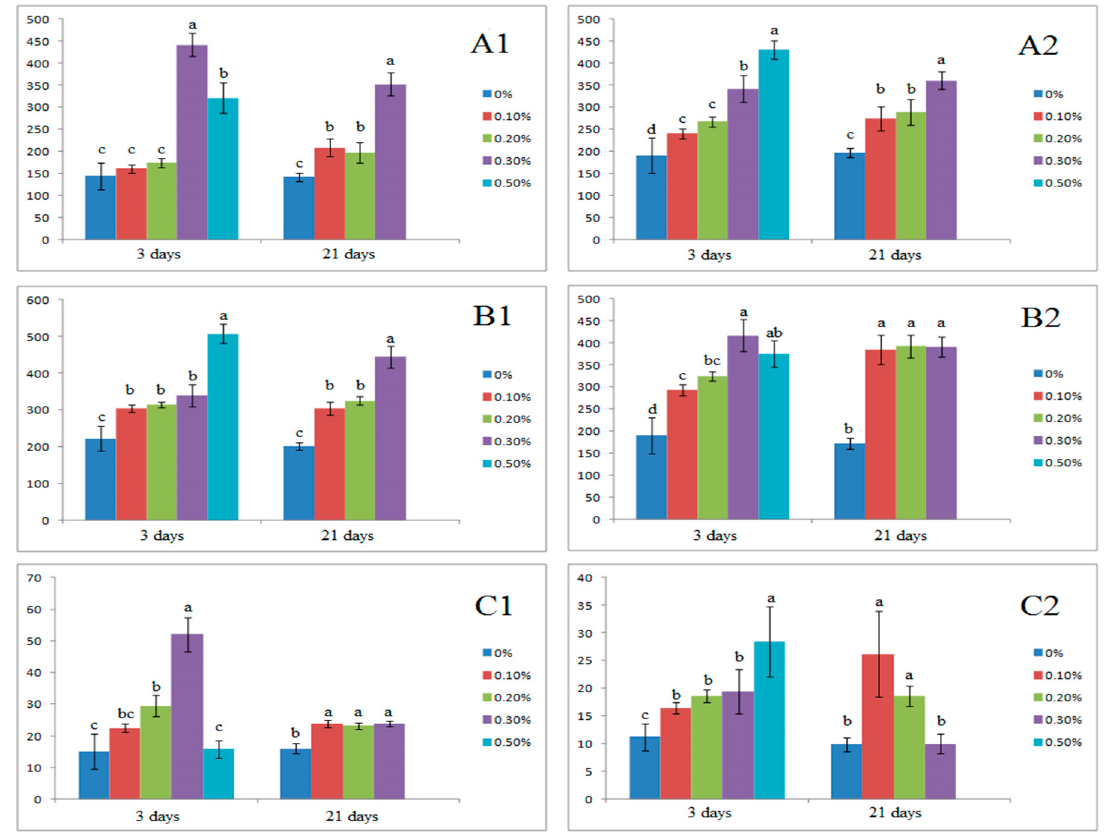
Figure 3. SOD activity in leaves ( A1 ), SOD activity in roots ( A2 ), CAT activity in leaves ( B1 ), CAT activity in roots ( B2 ), POD activity in leaves ( C1 ), and POD activity in roots ( C2 ) of mulberry plants grown for 3 and 21 days under increasing levels of soil salinity under greenhouse conditions. All enzyme activities are expressed as U mg − 1 fresh weight (FW). Data with the same letter are not significantly different ( P = 0.05).